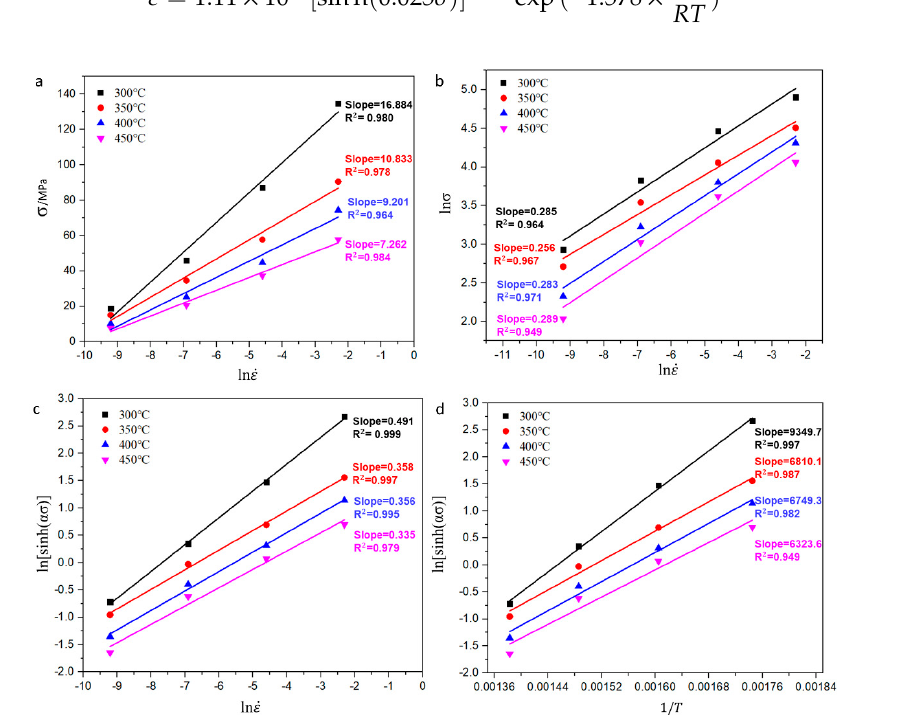
. ε − σ . ε − ln σ , , ( b ) ln